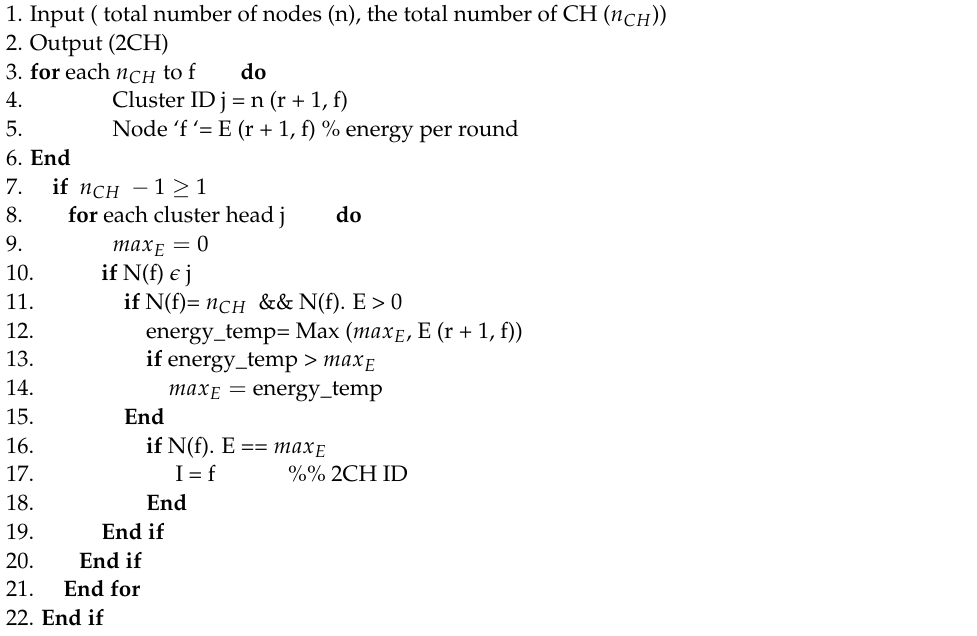
Algorithm 4 Selection of Secondary Cluster Head